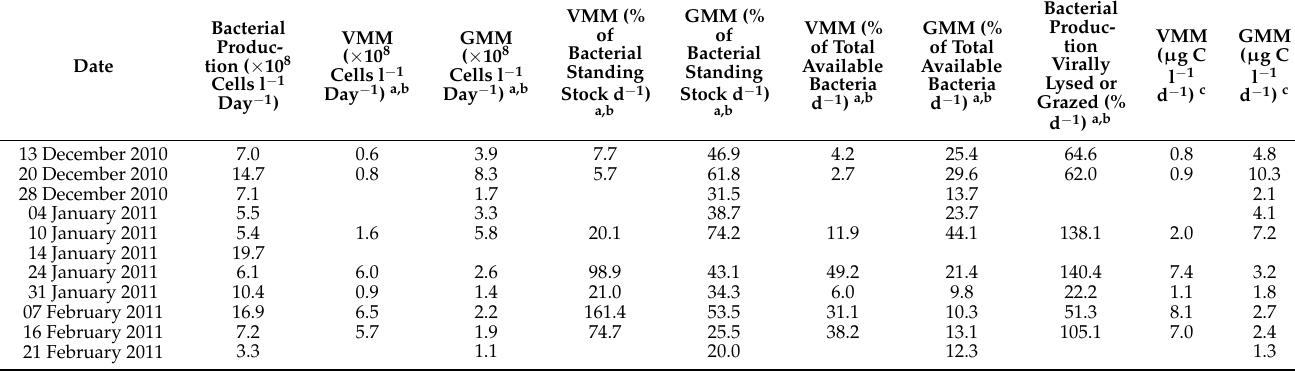
a Abbreviations: VMM, virus-mediated mortality; GMM, grazing-mediated mortality; SS, standing stock; and BP, bacterial production. b VMM, viral production/burst size of 41 according to Brum and Colleagues [32]; GMM, (specific grazing rate/net growth rate) × net bacterial production. VMM of bacterial standing stock = (VMM/SS) × 100. GMM of bacterial SS = (GMM/SS) × 100. VMM of total available bacteria = [VMM/(SS + BP)] × 100. GMM of total available bacteria = [GMM/(SS + BP)] × 100. Bacterial production virally lysed or grazed = [(VMM + GMM)/BP] × 100. c Bacterial carbon conversion factor of 12.4 fg C cell − 1 reported by Fukuda and colleagues [28].